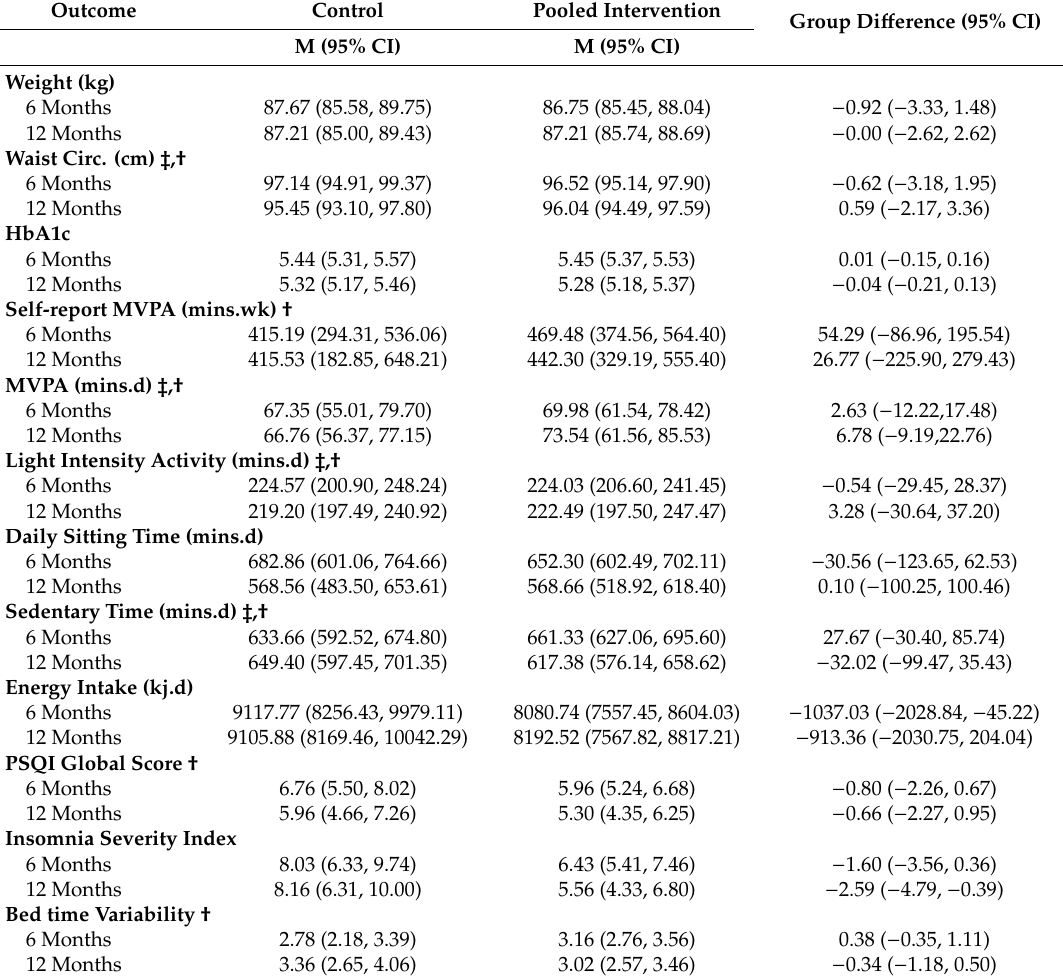
Table 2. Baseline adjusted group di ff erences between Pooled and Control groups at 6 months and 12